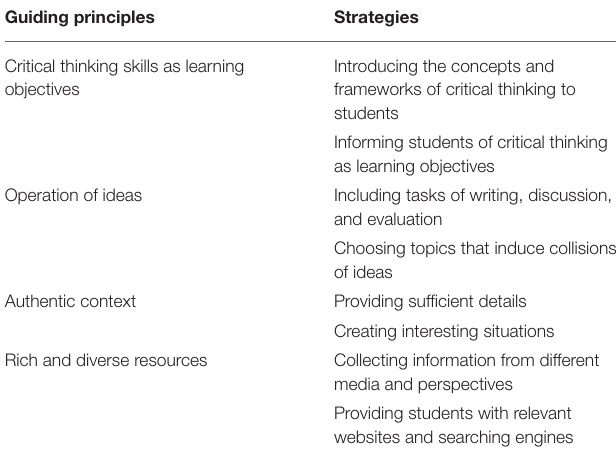
TABLE 1 | Strategies for pedagogical